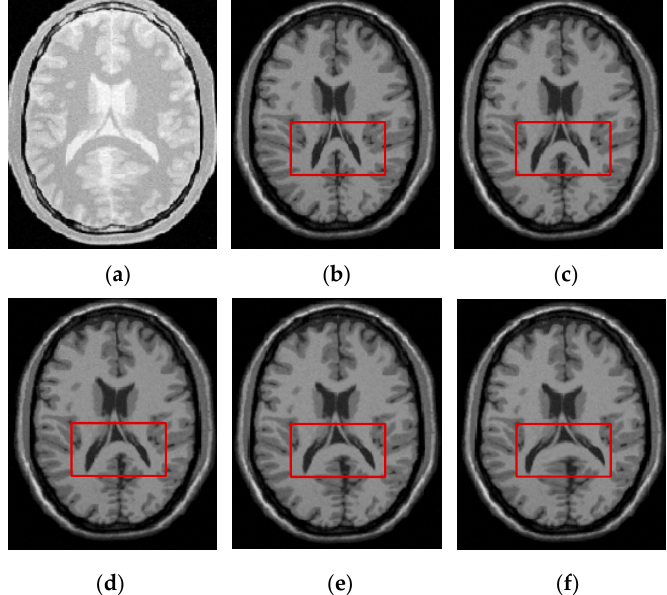
Figure 9. The registration results of all evaluated methods operating on 3D PD-T1 images. ( a ) PD image (reference image); ( b ) T1 image (float image); ( c ) ESSD; ( d ) MIND; ( e ) hybrid L-BFGS-B and cat swarm optimization (HLCSO); and, ( f ) FMIND.